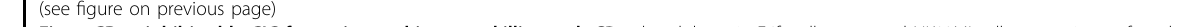
Fig. 5 CD44-inhibited heCIC formation and immune killing. a , b CD44 knockdown in F6ft cells promoted NK92MI cell penetration to form heCIC structures (E/T = 1:1, 8h co-culture). Data are means±SD of more than three images of 20× objective. n >300 cells analyzed for each clone. ** P <0.01. c CD44 knockdown in F6ft cells potentiated tumor cell killing by NK92MI cells (E/T = 1:1, 24h co-culture) quanti fi ed by counting using a hemocytometer. Data are means±SD of triplicate experiments. *** P <0.001; ns, not signi fi cant. d , e Overexpression of CD44 in A4S cells NK92MI cell penetration to form heCIC formation (E/T = 1:1, 8h co-culture). Data are means±SD of more than three images of 20× objective. n >300 cells analyzed for each clone. *** P <0.001. f CD44 overexpression in A4S cells inhibited tumor cell killing by NK92MI cells (E/T = 1:1, 24h co-culture) quanti fi ed by counting using a hemocytometer. Data are means±SD of triplicate experiments. * P <0.05, ** P <0.01; ns, not signi fi cant. g Representative images of heCIC structure formed between A4S cells (green) and PBMC-derived NK cells stained by antibodies against CD45 (red) and NKp46 (purple). Scale bar, 10µm. h , i CD44 knockdown promoted heCIC formation (8h co-culture) and tumor cell killing by PBMC-derived NK cells (24h co-culture), (E/T = 1:1) quanti fi ed by counting using a hemocytometer. Data are means±SD of triplicate experiments. ** P <0.01, *** P <0.001. j , k CD44 overexpression inhibited heCIC formation (8h co-culture) and tumor cell killing by PBMC-derived NK cells (24h co-culture), (E/T = 1:1) quanti fi ed by counting using a hemocytometer. Data are means±SD of triplicate experiments. ** P <0.01, *** P